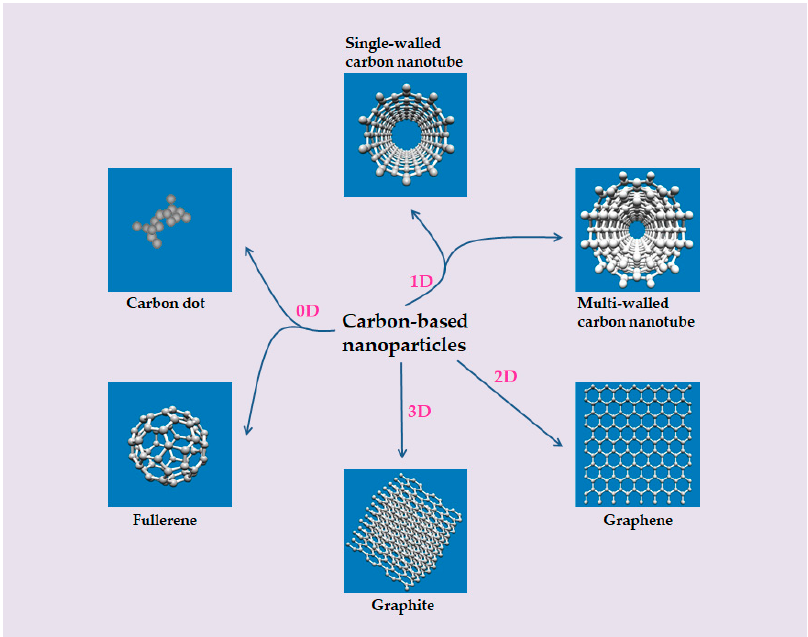
Figure 1. Carbon-based NPs in different dimensions. Zero-dimensional carbon-based NPs: C-dot and fullerene. One-dimensional carbon-based NPs: SWCNT and MWCNT. Two-dimensional carbon-based NPs: graphene. Three-dimensional carbon-based NPs: graphite.